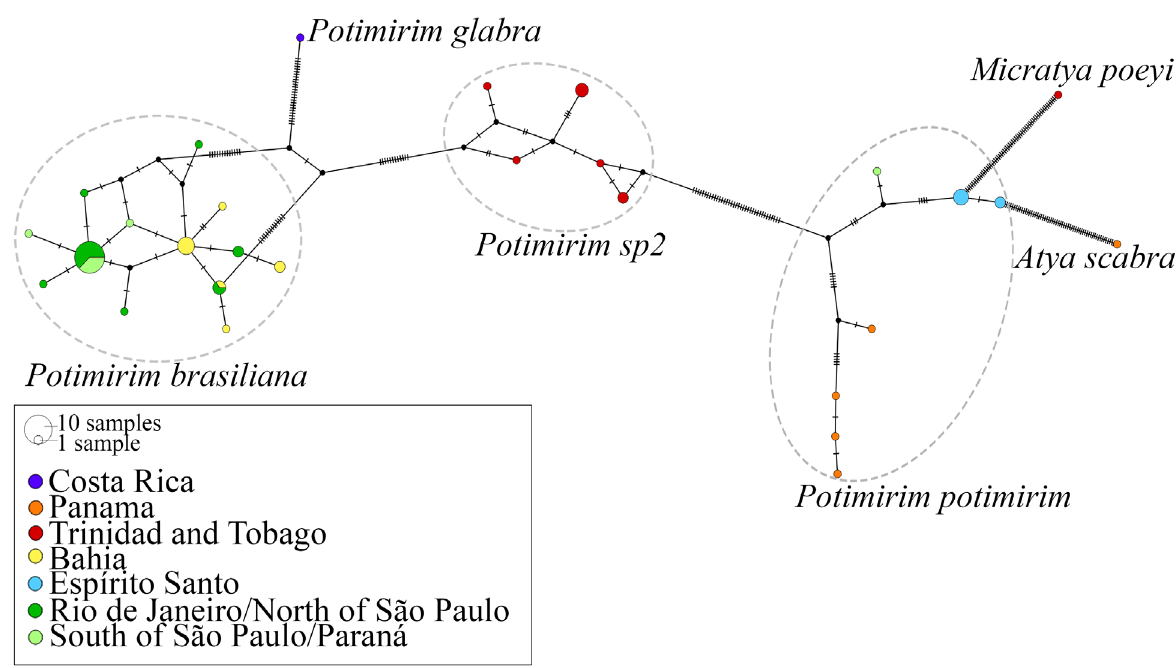
Figure 3. Haplotype network based on COI (530 bp) for populations of Potimirim and two outgroups ( Atya scabra and Micratya poeyi